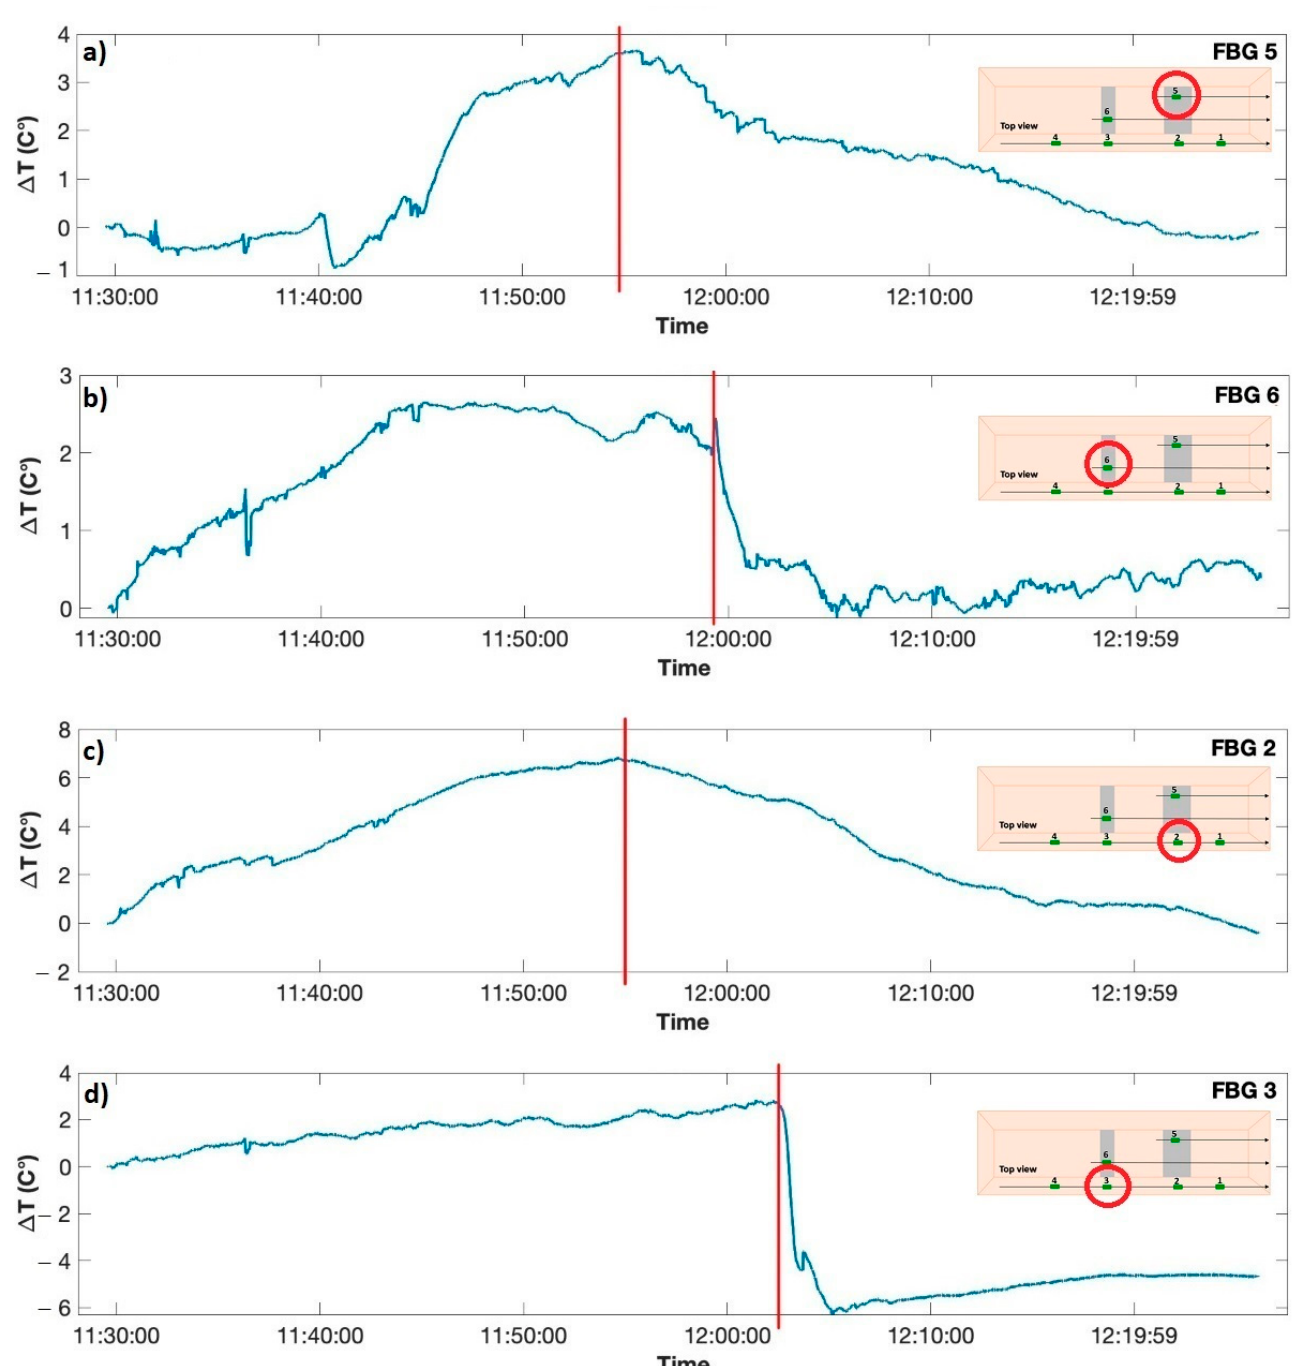
Figure 6. Temperature profiles as a function of time for different FBG sensors placed ( a ), ( b ) inside the seepage zones (FBG 5 inside the wider zone and closer to the river side; FBG 6 inside the narrower zone); ( c , d ) at the exits of seepage zones (FBG 2 at the exit of the wider zone and FBG 3 at the exit of the narrower zone). See Figure 2b for location map of fiber optic sensors.